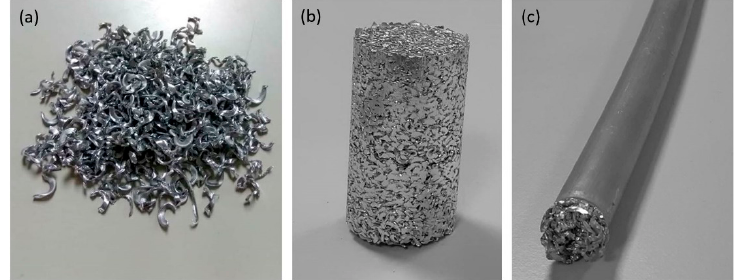
Figure 1. Material formation during solid state recycling (SSR) process: ( a ) aluminum chips ( b ) chips-based billet ( c ) extruded bar. Table 2. Chemical composition of aluminum alloy EN AW 6082. Table 3. Turning parameters for the fabrication of the chips and geometric chip characterization. Element Turning Parameters Min.–Max.